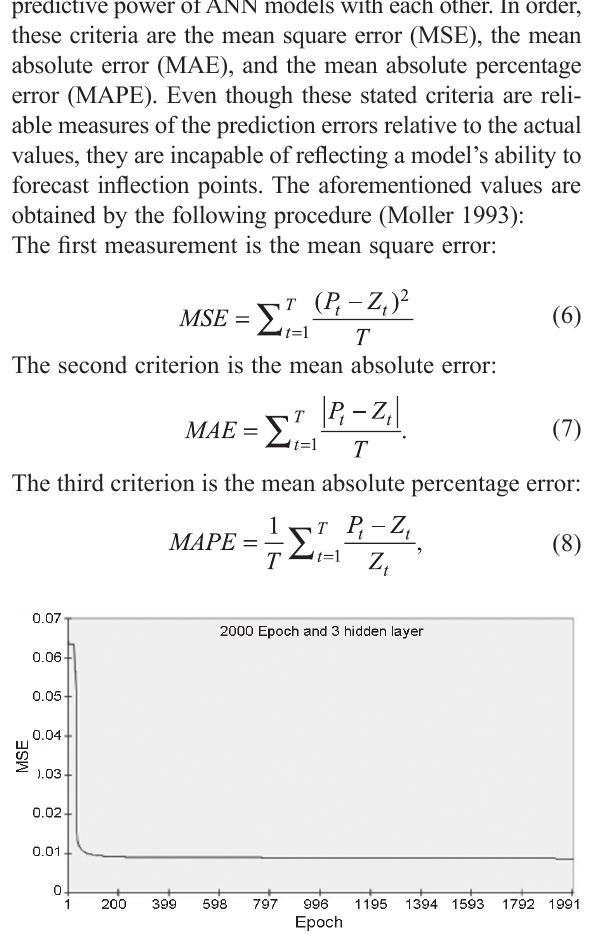
Fig. 2. ANN Model’s training